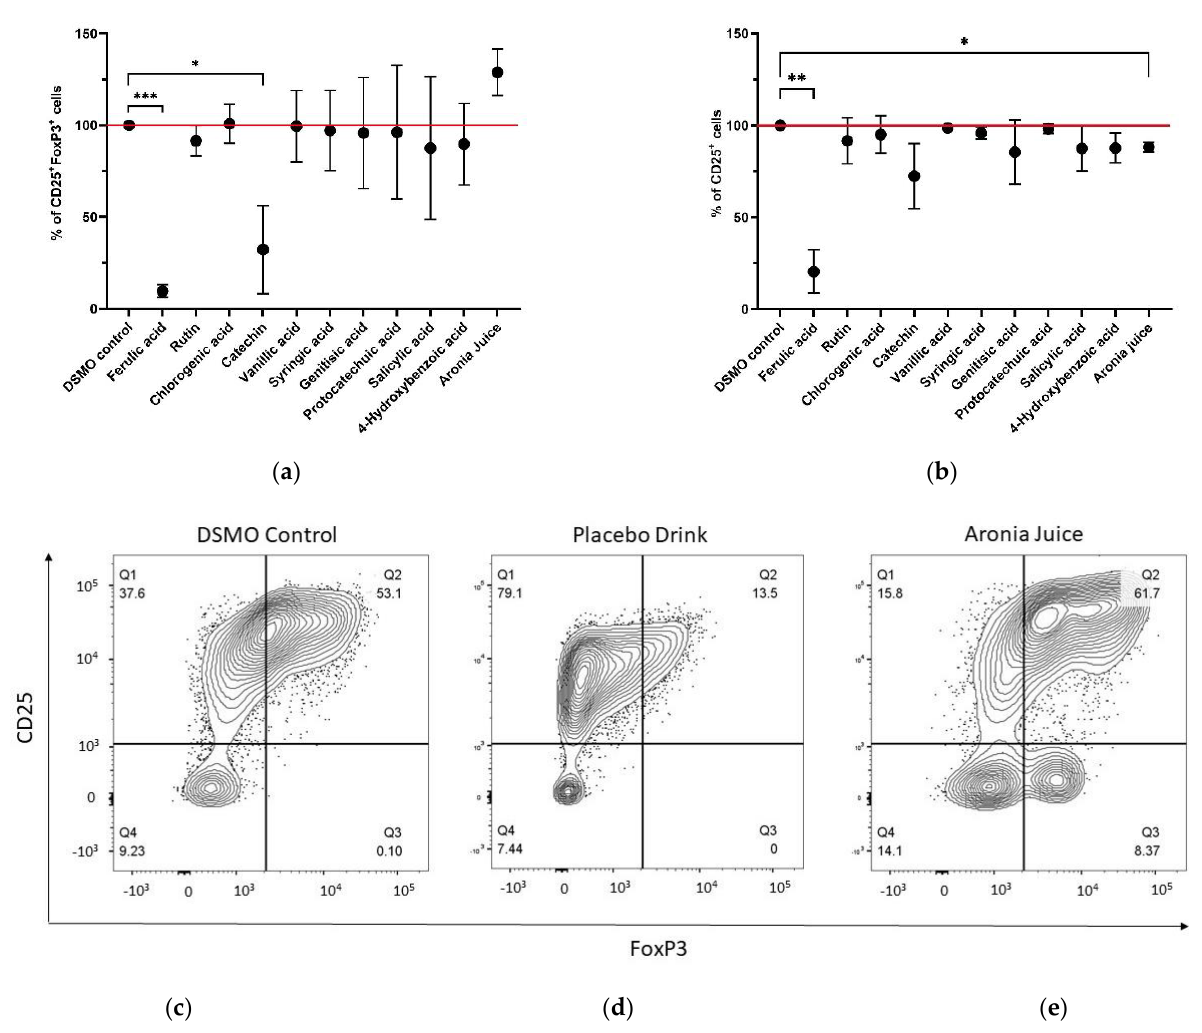
Figure 4. Results of the Treg differentiation experiments. The effects of polyphenols typically present in aronia juice and the natural aronia juice on Treg differentiation and T cell activation have been tested in vitro. ( a ) Ferulic acid ( p = 0.0005) and catechin ( p = 0.0393) showed significant inhibitory effects on Treg differentiation whereas the aronia juice slightly promoted Treg differentiation (n.s.); ( b ) Ferulic acid ( p = 0.0072) and the aronia juice ( p = 0.0163) significantly inhibited CD25 expression. ( c – e ) Representative flow cytometry plots from the Treg differentiation experiments. Following the treatment of naïve CD4 + T cells with IL-2 and TGF-β1, T cells were analyzed for the expression of CD4, CD25, and FoxP3. The representative plots show the percentages of CD25 and FoxP3 cells by gated CD4 + cells. Cultures treated with DSMO ( c ) and placebo drink ( d ) did not exhibit a CD25 - FoxP3 + population; Cells treated with aronia juice ( e ) showed a unique population of CD25 negative cells that expressed FoxP3. p -values < 0.05 are marked with *, < 0.01 with **, and < 0.001 with ***. Abbreviations: Treg: regulatory T cell, iTreg: induced regulatory T cell, Ctrl: Control; DMSO: Dimethylsulfoxid.